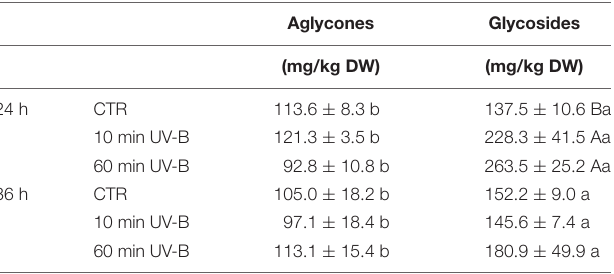
TABLE 1 | Concentration of total flavonol aglycones and glycosides in the UV-B-treated samples after 24 and 36 h from the UV-B exposure. Aglycones